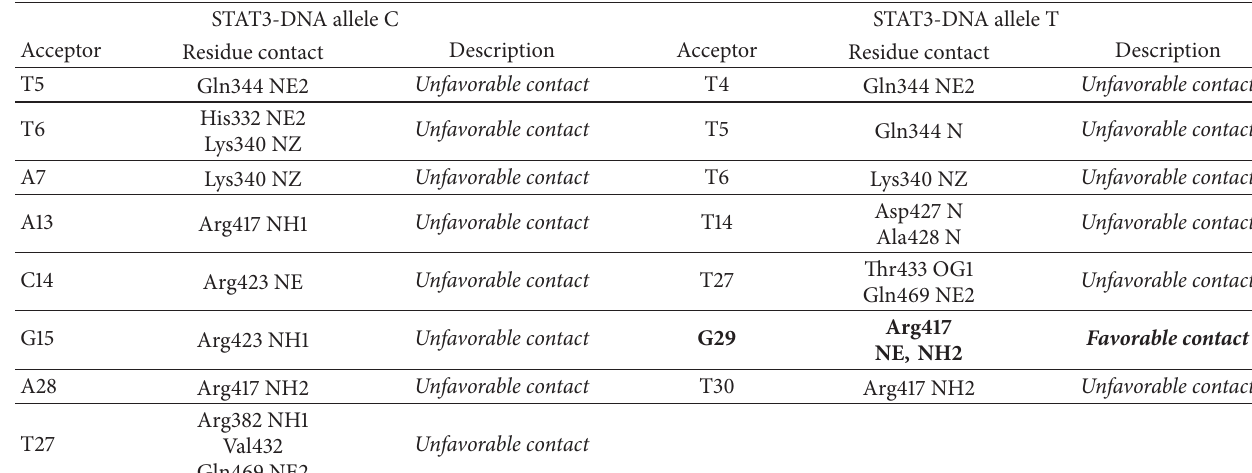
Table 3: Protein-DNA contacts (hydrogen bonds) observed in STAT3-DNA allele C/allele T. STAT3-DNA allele